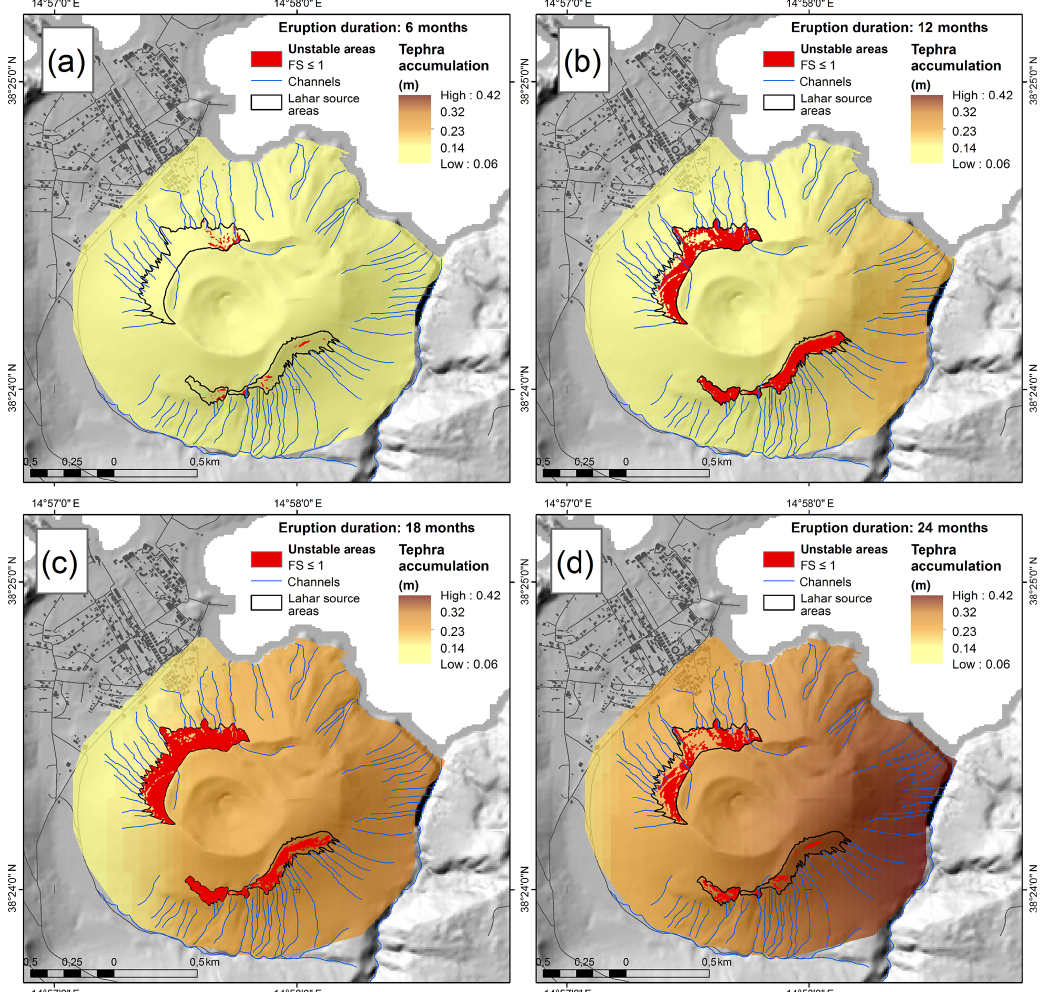
Figure 7. Probabilistic isopach maps (converted from the probabilistic isomass maps of Biass et al., 2016a, based on deposit density) and corresponding instability maps compiled with TRIGRS for a Vulcanian eruption with the following: (a) an eruption duration of 6 months and a probability of occurrence of 25%; (b) an eruption duration of 12 months and a probability of occurrence of 25%; (c) an eruption duration of 18 months and a probability of occurrence of 25%; (d) an eruption duration of 24 months and a probability of occurrence of 25%. The rainfall intensity is 6.4mmh − 1 with a duration of 5h for all the scenarios, and the parameters for the 1888–1890 Vulcanian deposits are listed in Table 3.